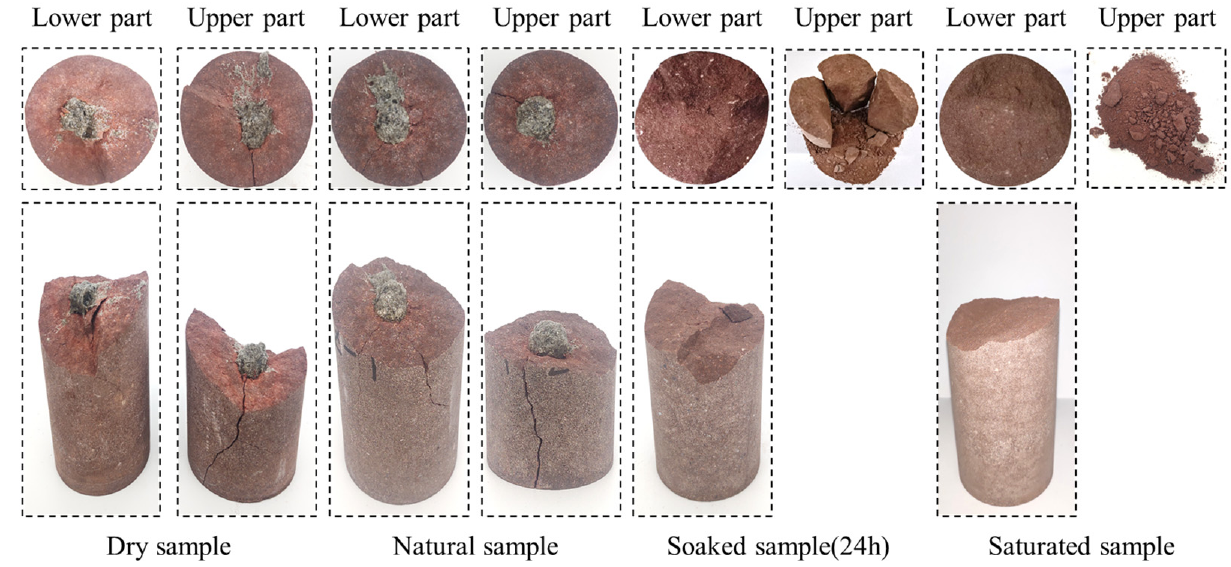
Figure 4. Fracture characteristics of red sandstone with different water contents.